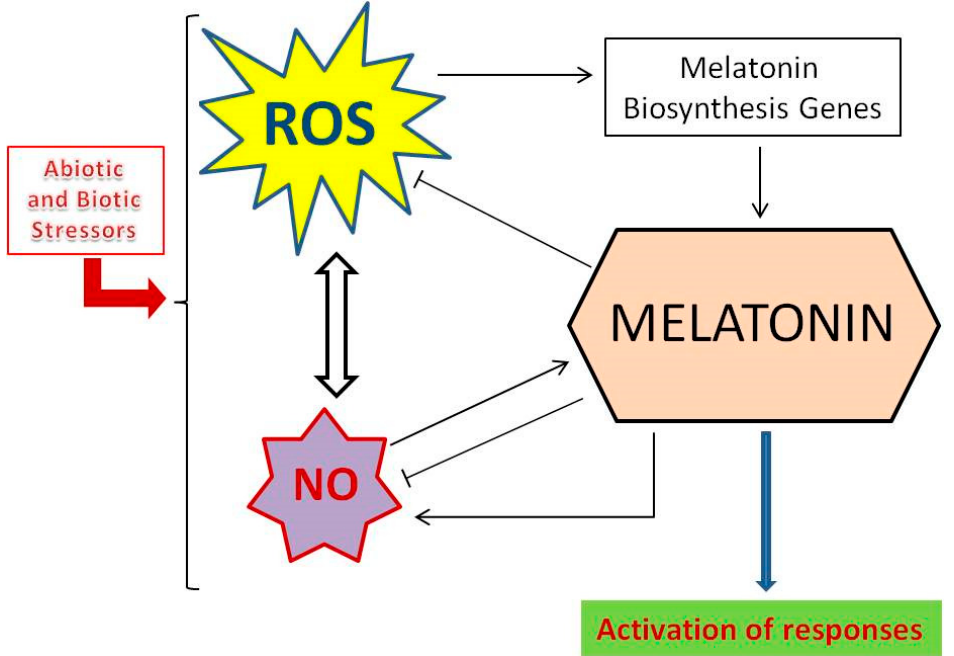
Figure 2. Effect of abiotic/biotic stressors on the antioxidant network ROS/NO/melatonin.